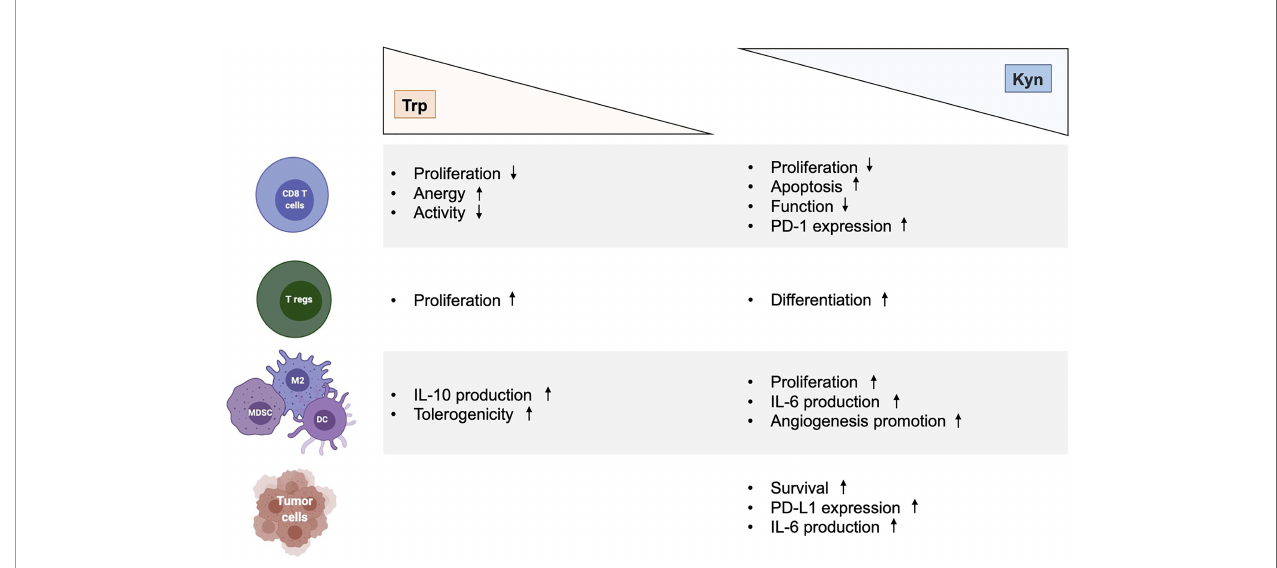
FIGURE 2 | Immunological effects of kynurenine and tryptophan metabolites in cancer. Effects of Trp depletion and Kyn augmentation on CD8 T cells, regulatory T cells, myeloid cells (MDSC, M2, DC) and tumor cells. DC, dendritic cell; Kyn, kynurenine; IL-6, interleukin 6; MDSC, myeloid-derived suppressor cell; M2, type 2 macrophage; Trp,